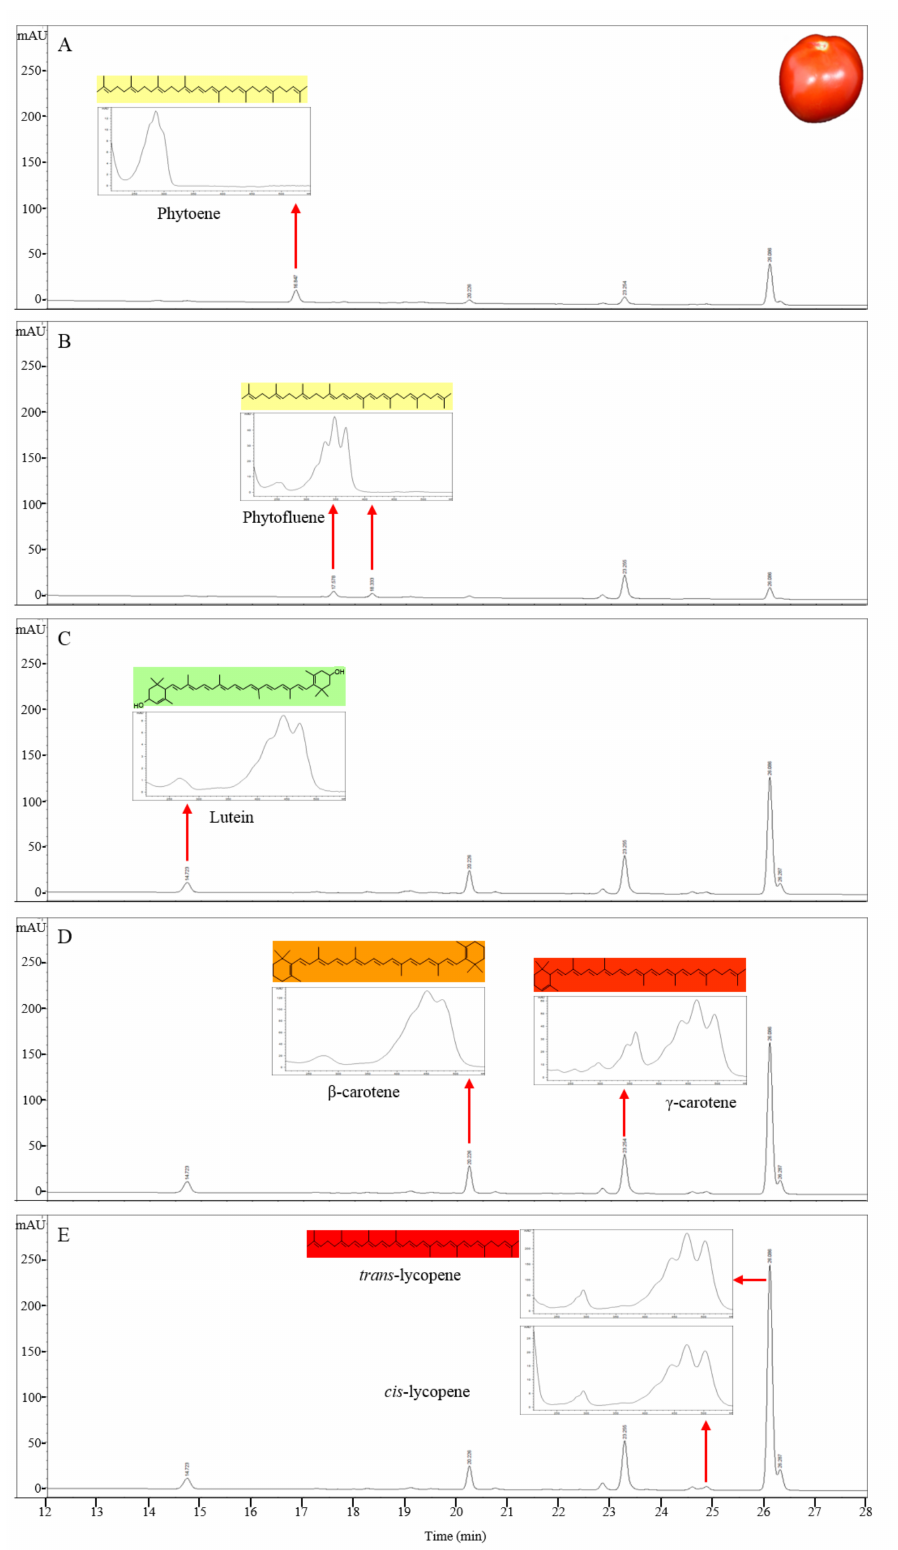
Figure 1. HPLC profile of carotenoids as determined by their absorption between 286 and 471 nm in red tomato (LA3475). The carotenoid compounds were detected by their absorption at five wavelengths and were identified by their absorption maxima and spectrum. ( A ) 286 nm; ( B ) 348 nm; ( C ) 434 nm; ( D ) 450 nm; ( E ) 471